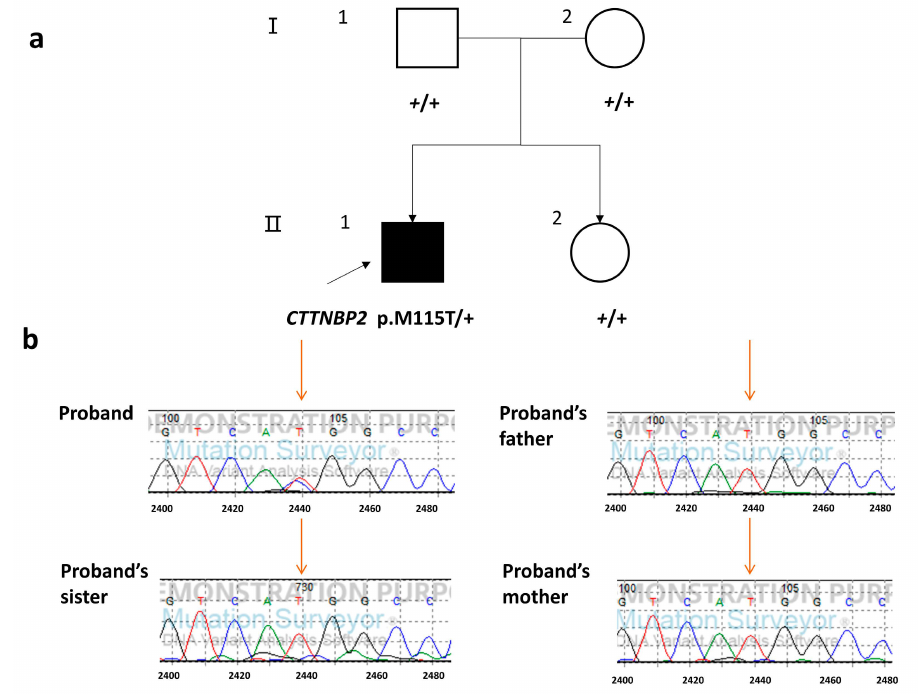
Figure 2. De novo CTTNBP2 variant confirmed in a quad family affected by ASD: ( a ) CTTNBP2 p.M115T (c.344T > C) was identified in the proband as a de novo mutation (II-1), +, wild type; ( b ) Sanger sequencing confirmed the presence of CTTNBP2 p.M115T (c.344T > C) in the proband as a de novo